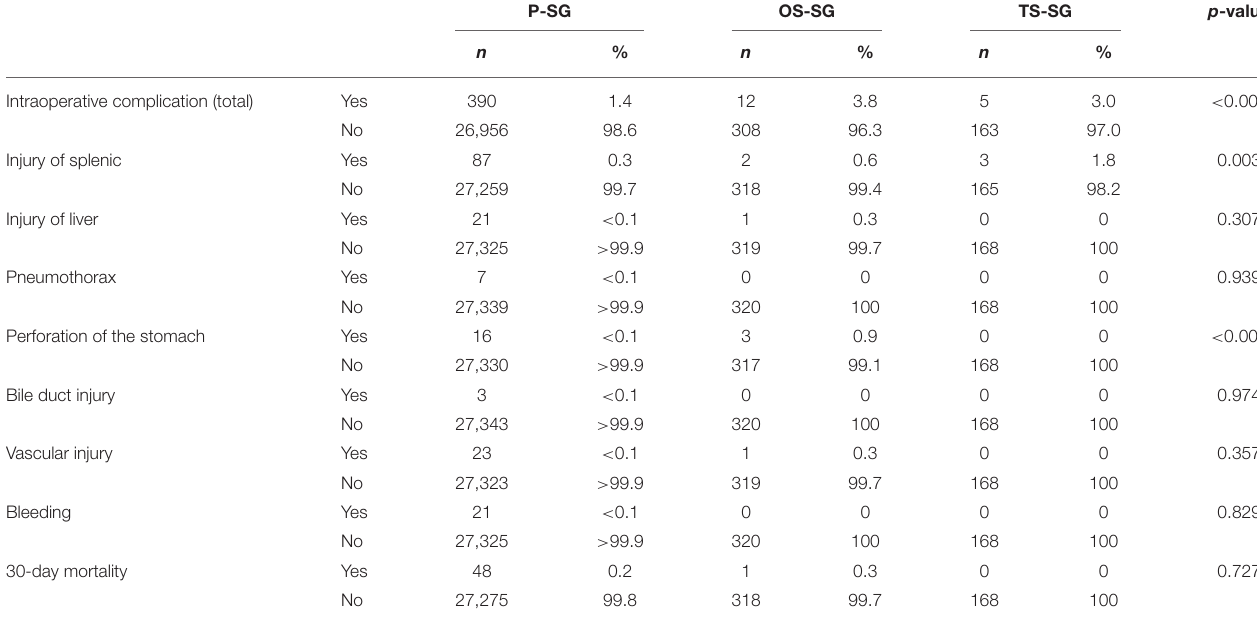
TABLE 4 | Intraoperative